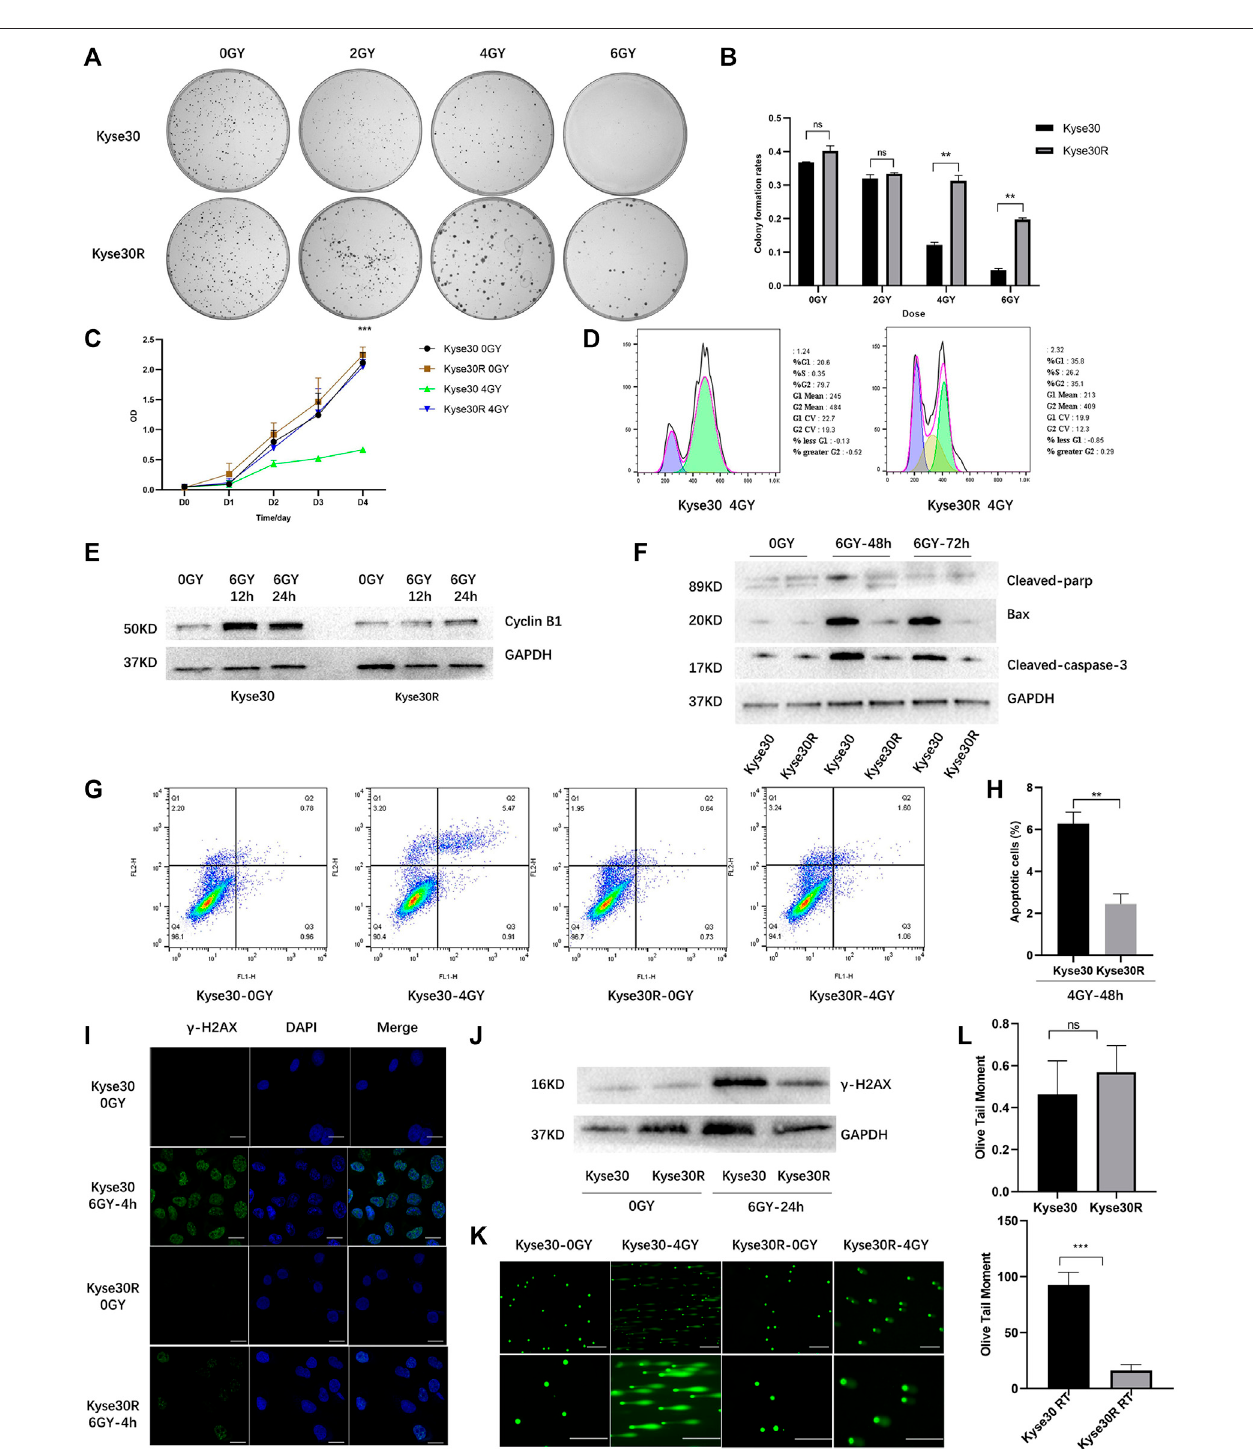
FIGURE1| Radioresistant ESCC celllinewasestablished. (A,B) Cloneformationshown thenumber ofcolonies ofKyse30R and Kyse30 cellsafter irradiation (The Yaxiswastheratioofthenumberofclonestothatofcellsseeded). (C) CCK-8assaysshowntheproliferationabilitiesofKyse30RandKyse30cellsafterirradiation. (D,E) Radiotherapy induced cell cycle arrest in Kyse30R and Kyse30 cells. (F) Expressions of several apoptosis-related proteins in Kyse30R and Kyse30 cells. (G,H) RadiotherapyinducedcellapoptosisinKyse30RandKyse30cells(FL1:AnnexinV-FITC,FL2:PI;Q2:Lateapoptosis,Q3:Earlyapoptosis).Immuno fl uorescence (I) (Green, γ -H2AX staining; Blue, DAPI nuclear staining; Scale bar 30 μ m), Western blot (J) and neutral comet assays (K, L) (Scale bar 150 and 100 μ m) shown DNA damage in both Kyse30R and Kyse30 cells after radiotherapy. Data are expressed as mean ± SD, ns > 0.05, ** p < 0.01, *** p < 0.001.